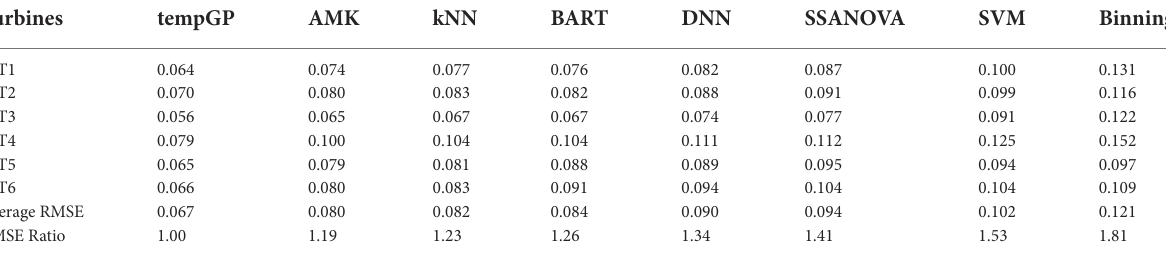
TABLE 1 Comparingvariousdatascience-basedpowercurvemethods.ReportedbelowaretheRMSEvaluesbasedonarandomizedfive-foldcross validation.TheresultsofAMK,KNN,BART,SSANOVA,andbinningaretakendirectlyfromTable 5.7ofDing (2019);theresultsoftempGPandSVMare obtainedusingtheDSWERpackage(Kumar et al., 2020);andDNNisobtainedusingtheDSWEPythonpackage(Kumar et al., 2022).